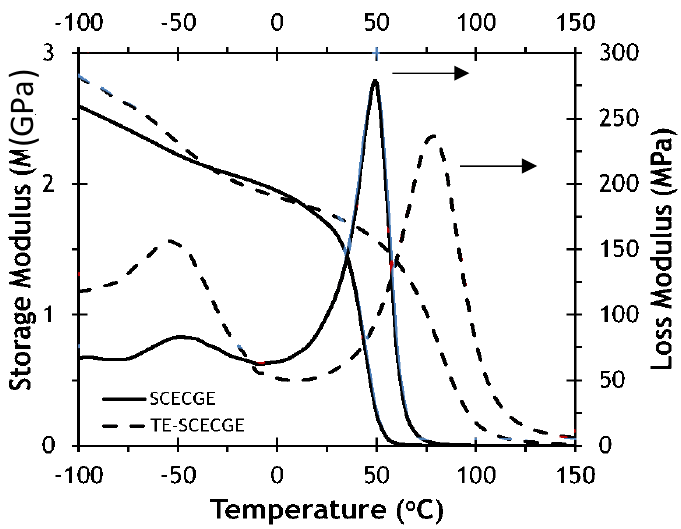
Figure 5. Temperature dependence of the storage and loss modulus of SCECGE and TE-SCECGE cured with PACM at stoichiometry.